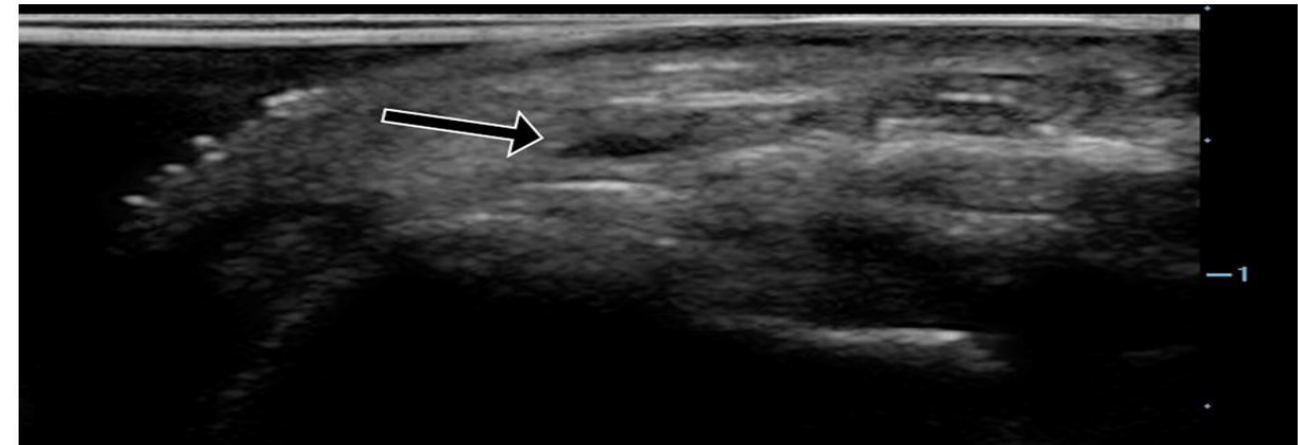
Figure 4b. Ultrasound of the radial artery with pressure applied, beginning to show coaptation of the anterior and posterior walls representing diastolic pressure (arrow).